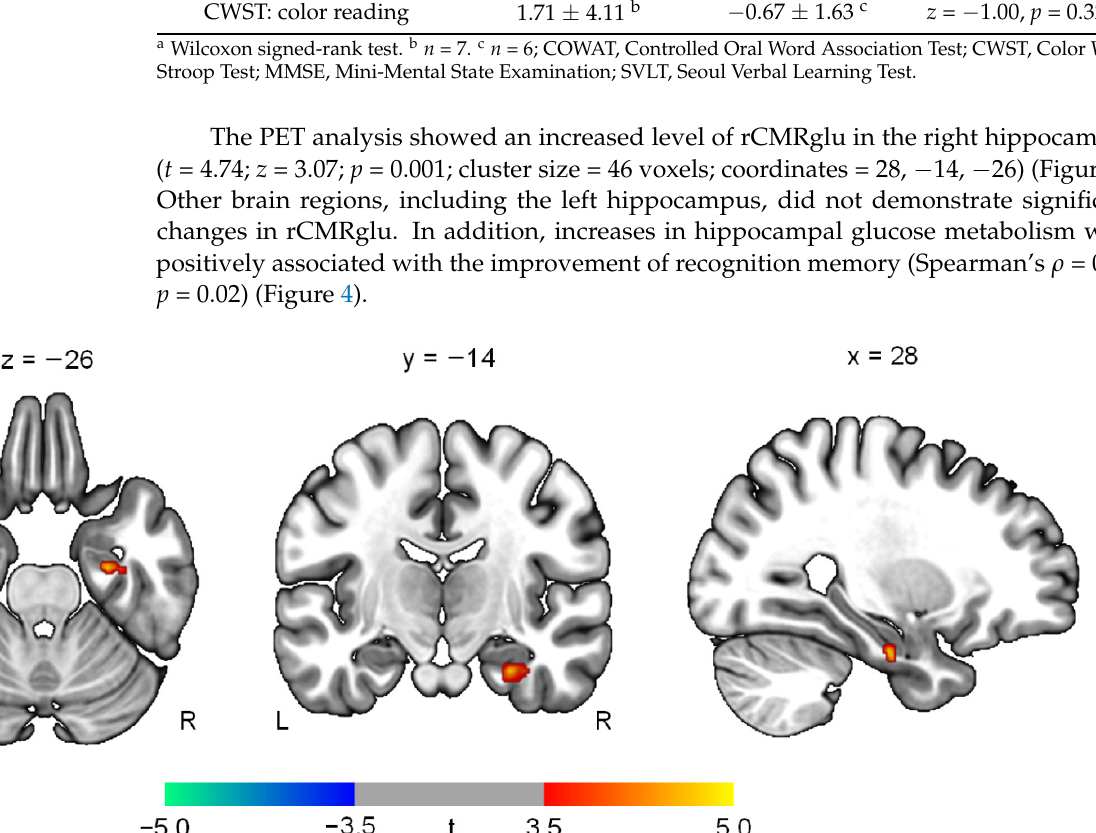
Table 2. Changes in neuropsychological test results after transcranial focused ultrasound.